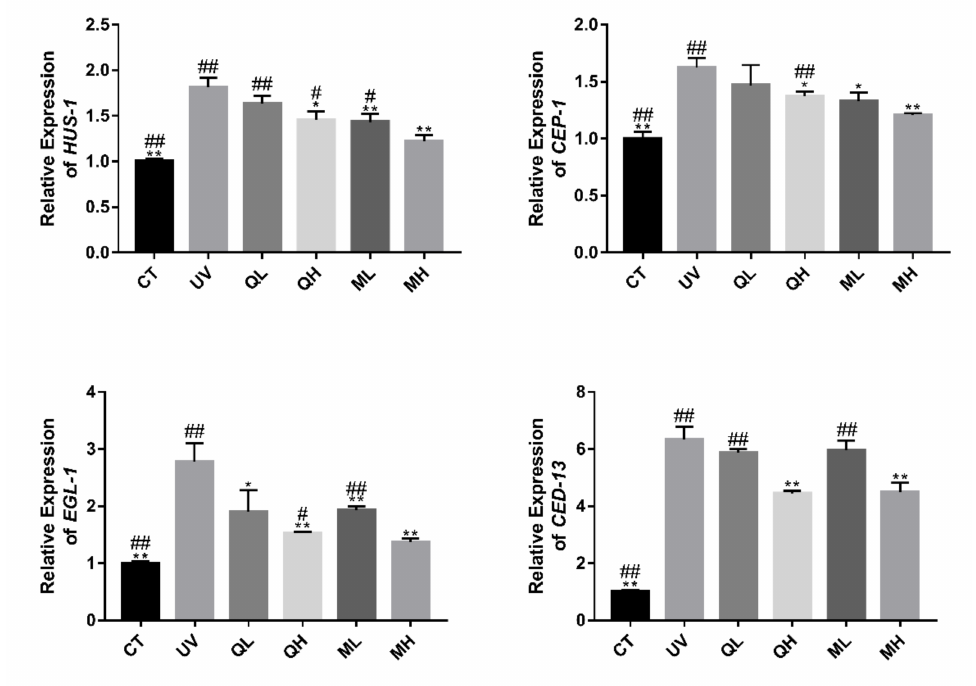
Figure 7. Changes in the relative expression of apoptosis-related genes HUS-1 , CEP-1 , EGL-1 and CED-13 . All data are mean ± SEM and were analyzed by two-tailed Student’s t -test, n = 3, * p < 0.05, ** p < 0.01 compared to UV group. # p < 0.05, ## p < 0.01 compared to MH